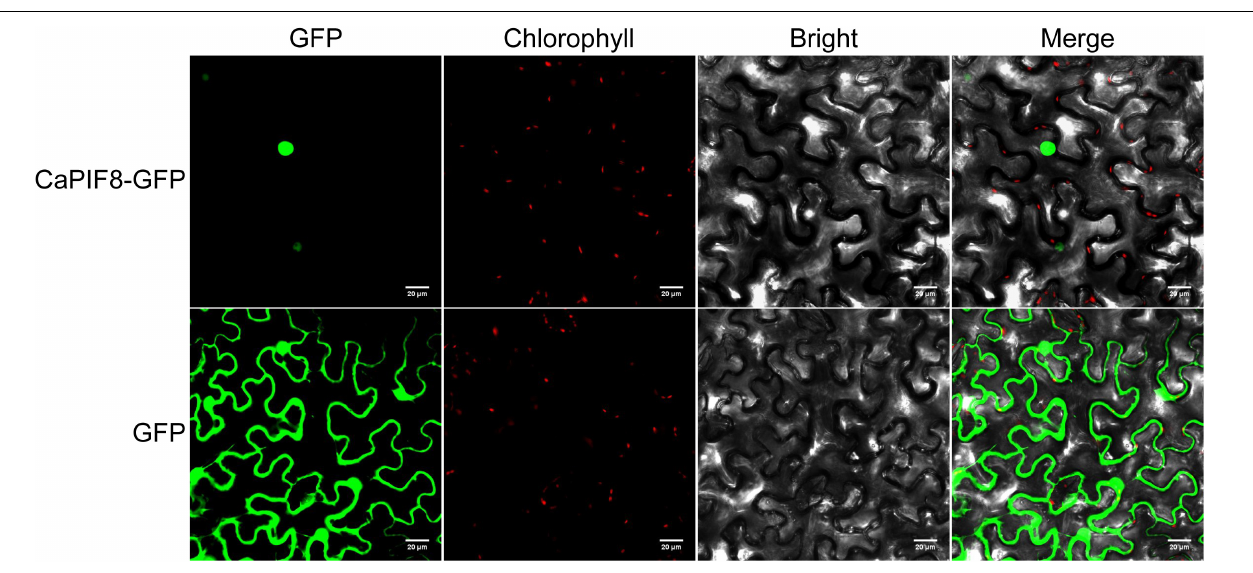
FIGURE 6 | Subcellular localization of CaPIF8 in Nicotiana benthamiana epidermal cells. The subcellular localization of CaPIF8-GFP in N. benthamiana epidermal cells was visualized using confocal laser scanning